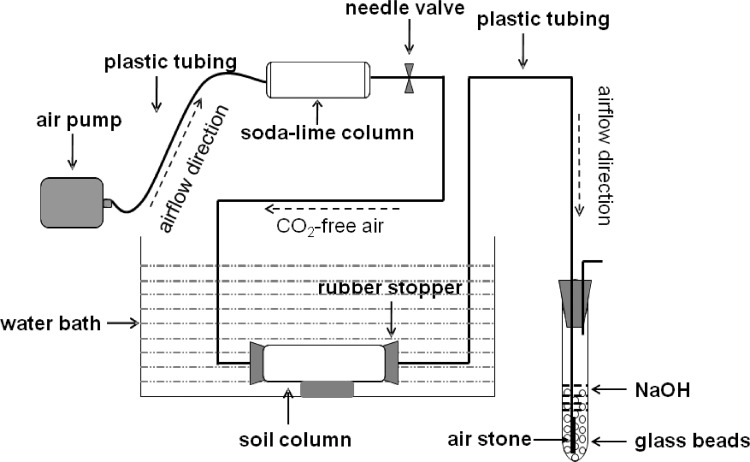
The dynamic CO2 trapping system for accurately measuring soil respiration and δ13C of respired CO2.